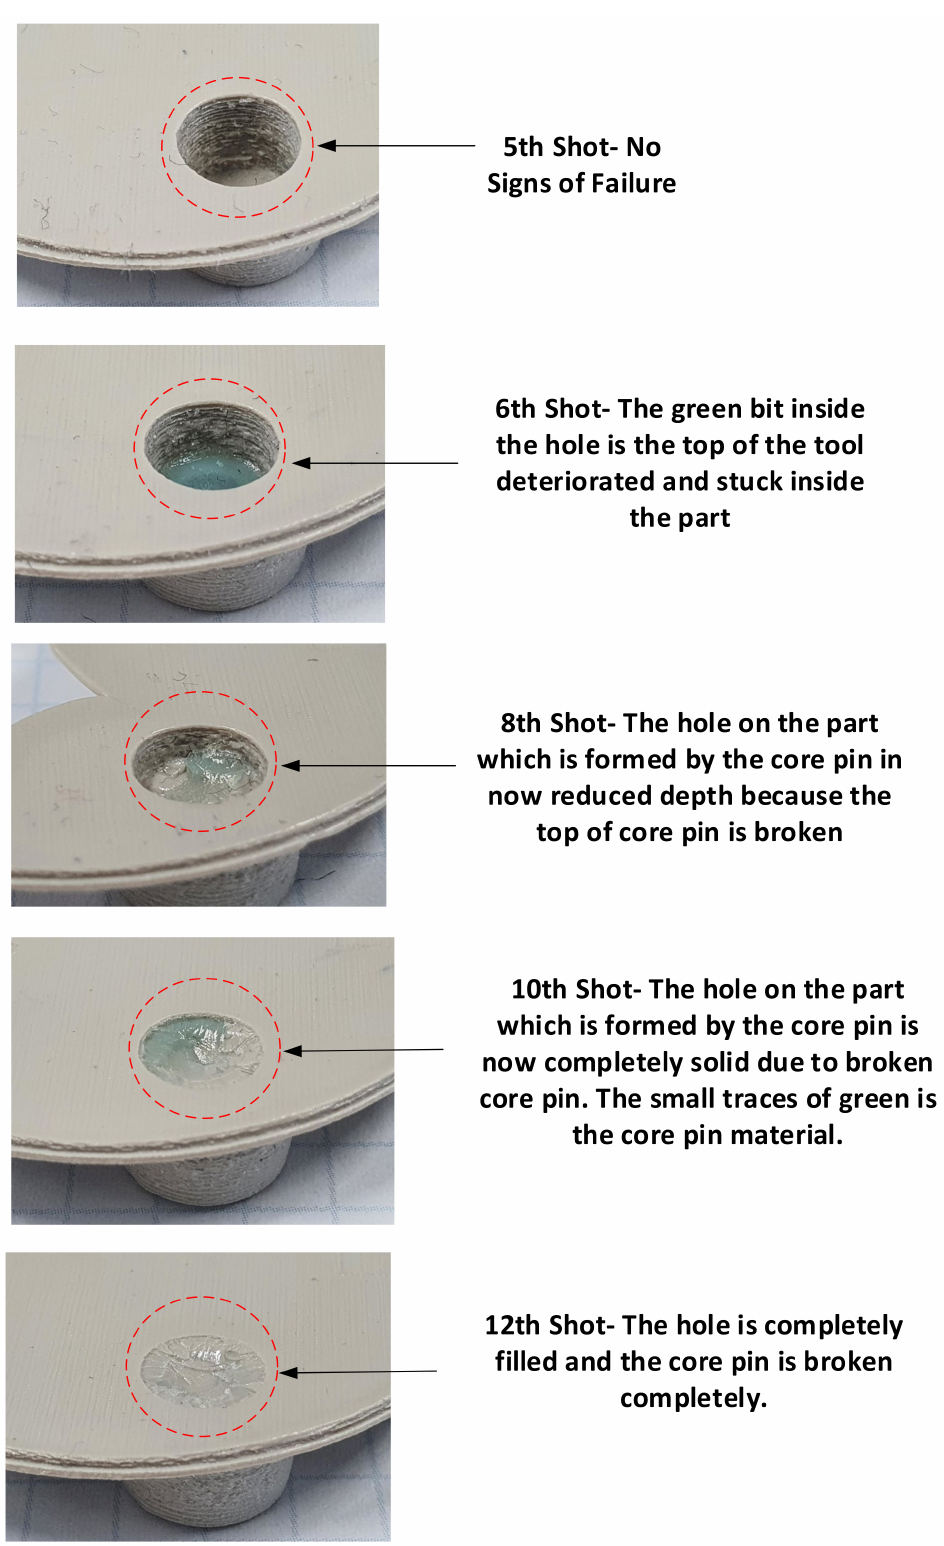
Figure 30. Progressive reduction in depth of the M5 core hole as a result of deterioration of the M5 core